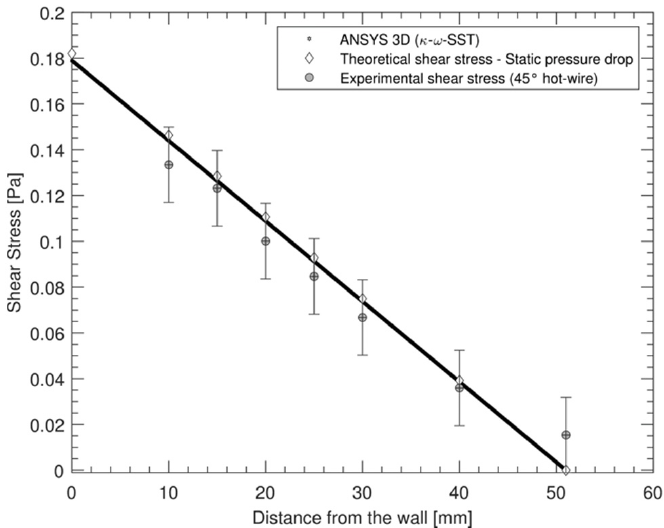
Figure 9. Comparison of experimental, theoretical and CFD results of the shear stress distribution across the pipe.